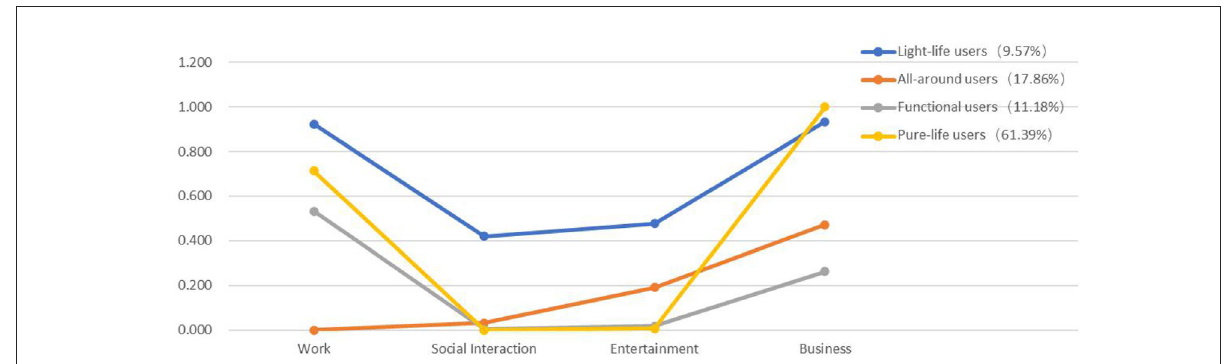
FIGURE1 Item response probabilities and prevalence for the four-class